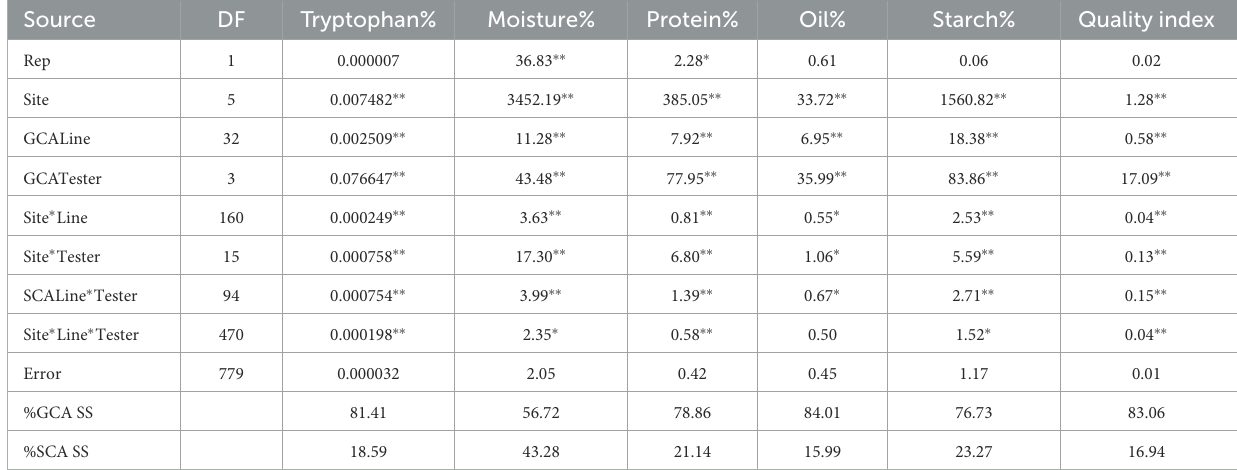
TABLE 6 Mean squares from combined analysis of variance for general and specific combining ability for six quality traits of 33 inbred lines and four testers across six sites during the 2017/2018 and 2018/2019 cropping seasons. Source